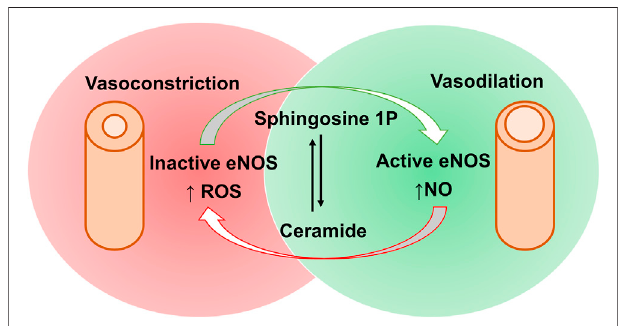
FIGURE 3 | Contradictory effects of sphingosine-1 phosphate and ceramides via activation and inactivation of eNOS and the subsequent impactsonbloodvessels.Sphingosine-1phosphatecauseseNOSactivation, increasing nitric acid (NO) production and subsequent vasodilation. This can be opposed by ceramides mediated eNOS inactivation, increasing reactive oxygen species (ROS) production leading to vasoconstrictive effects. [eNOS, endothelial nitric oxide synthase; S1P, sphingosine-1 phosphate].